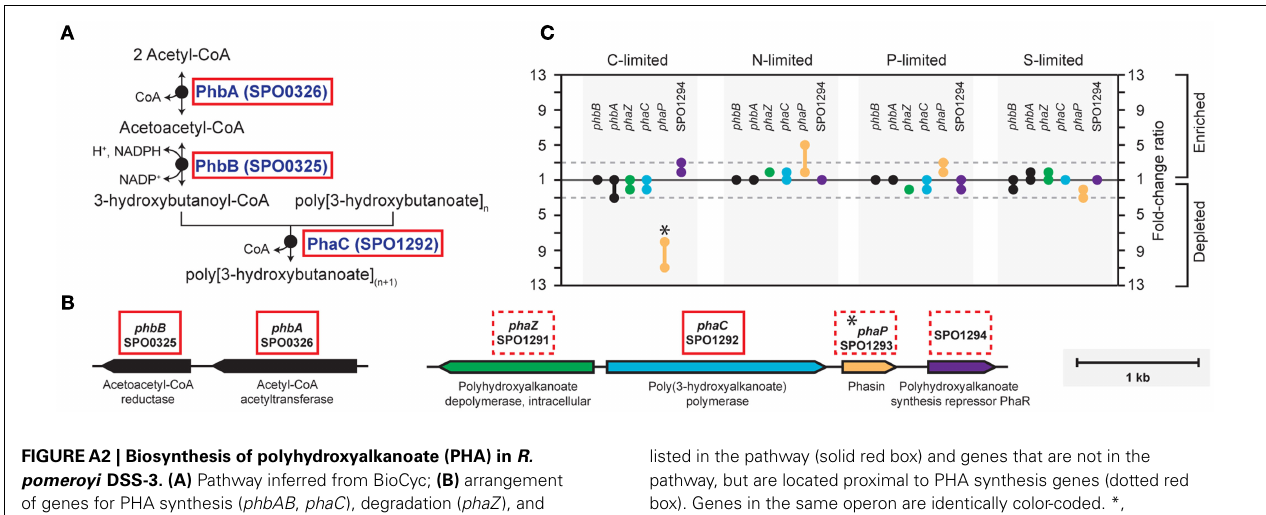
FIGUREA2 | Biosynthesis of polyhydroxyalkanoate (PHA) in R. pomeroyi DSS-3. (A) Pathway inferred from BioCyc; (B) arrangement of genes for PHA synthesis ( phbAB , phaC ), degradation ( phaZ ), and regulation ( phaR ) on R. pomeroyi DSS-3 chromosome; (C) transcriptional ratios for relevant genes; values are shown for genes